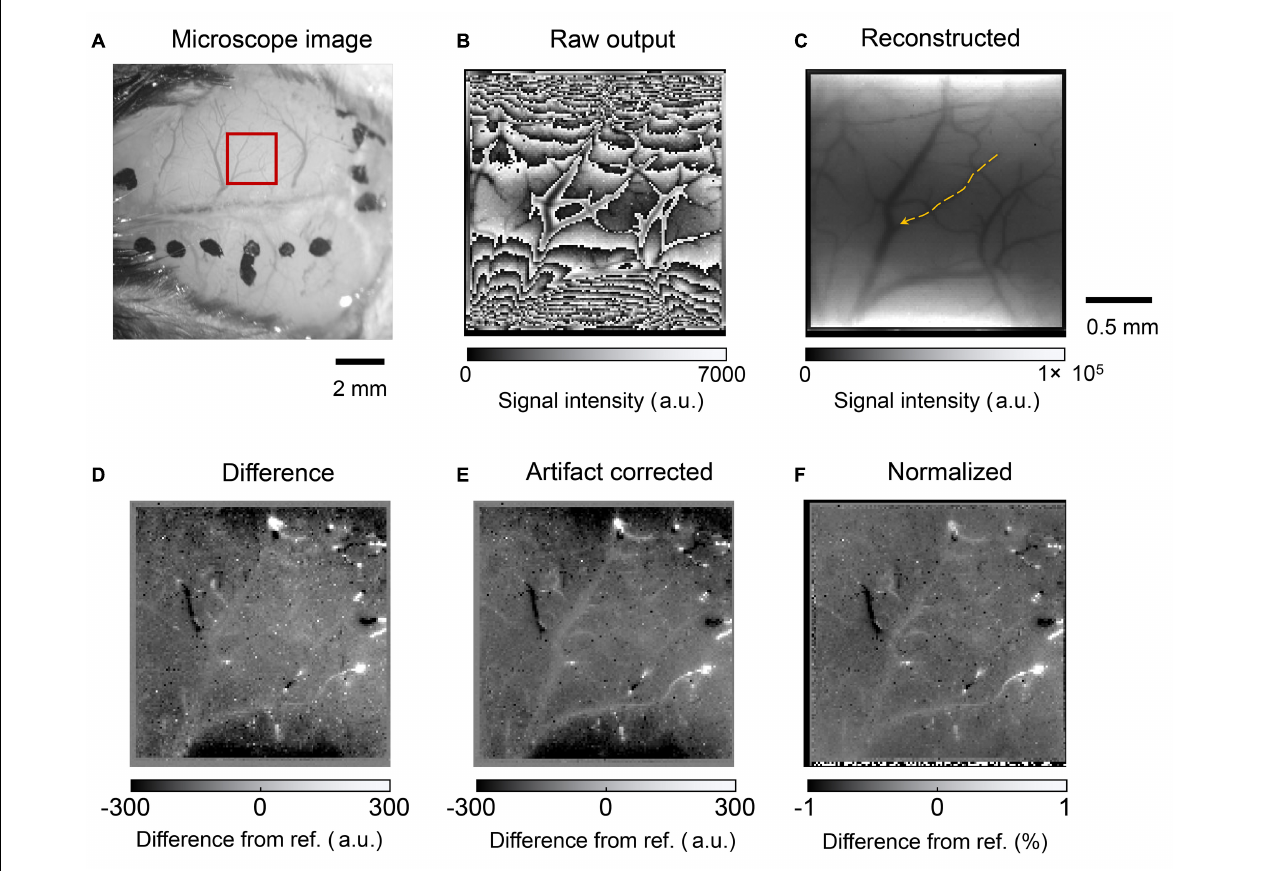
FIGURE 11 | (A) Photograph of the mouse brain surface. The red square shows the position where the image sensor was placed. (B) Raw output image from the self-reset sensor. (C) Reconstructed image. The orange arrow indicates the blood vessel analyzed in Figure 12 . (D) Difference image from the reference. White and black spots are observed because high output value change occurs when the number of self-resets changes. (E) Image after noise and artifact reduction. (F) Image normalized by the reconstructed